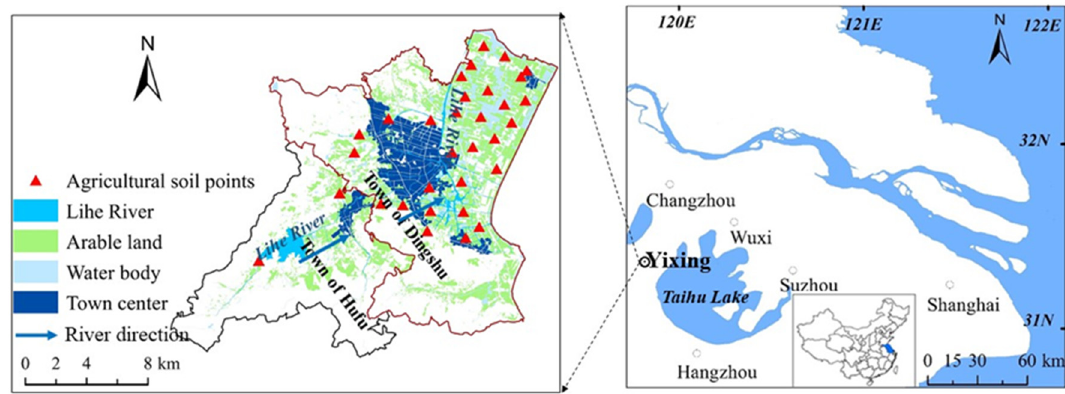
Figure 1. Location of the study area and distribution of sampling points.